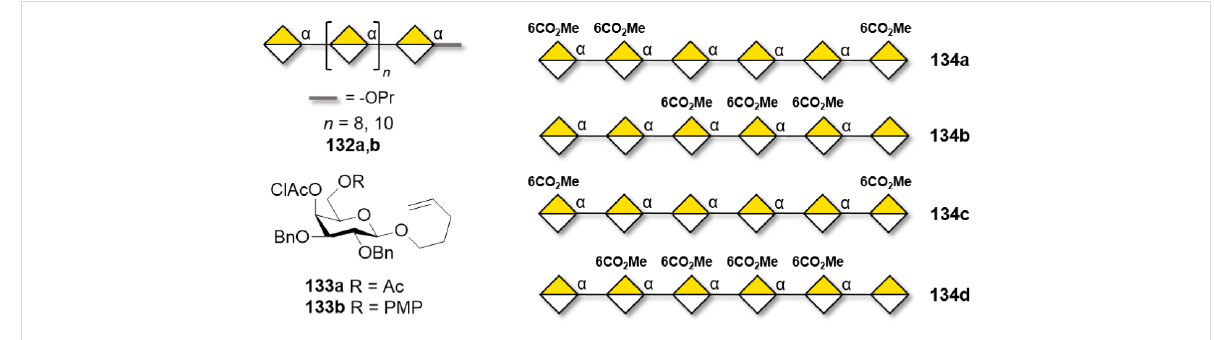
Figure 12: Homogalacturonan oligosaccharides synthesized to date. Access to different patterns of methyl-esterification could be controlled using BBs 133a and 133b bearing different C-6 PGs (i.e., Ac or PMP).